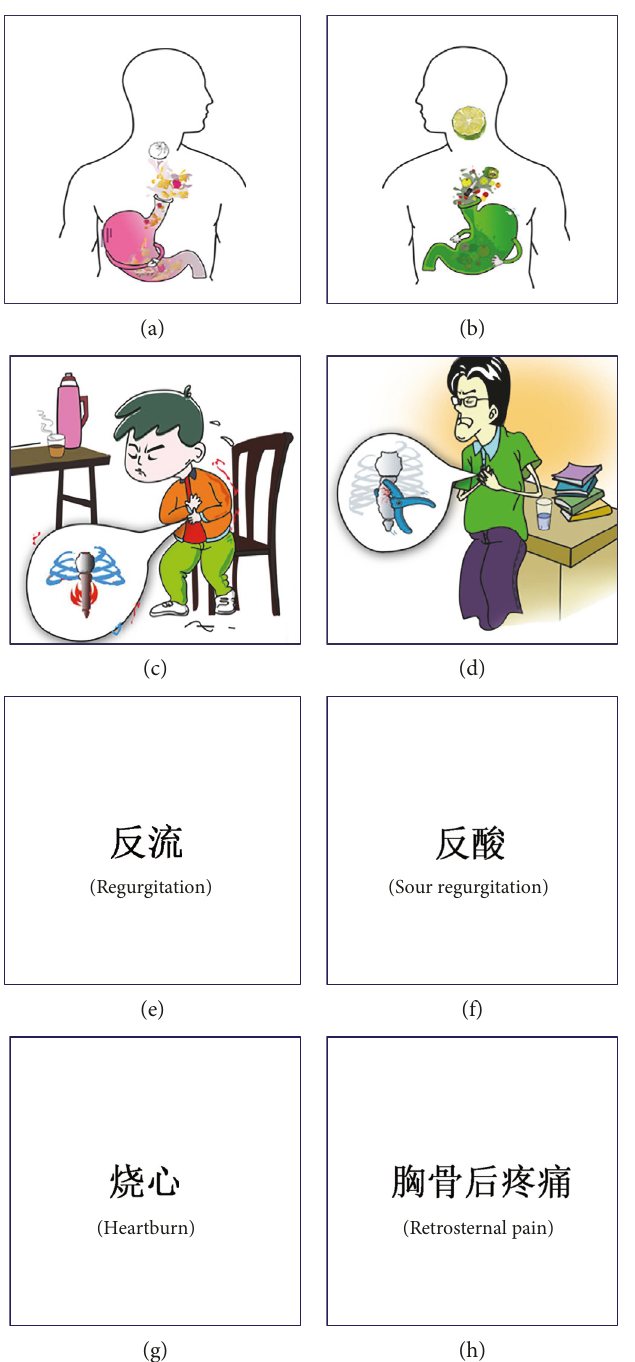
Figure 1: Pictograms denoting the classic gastroesophageal re fl ux symptoms. Pictograms denoting re fl ux symptoms were created by the joint e ff orts of an artist and a gastroenterologist specialized in GERD. (a) Pictogram denoting regurgitation, the feeling of the fl owing back of stomach contents. (b) Pictogram denoting sour regurgitation, the feeling of acidic stomach content fl owing into the pharynx and mouth. (c) Pictogram denoting heartburn, the feeling of burn behind the breastbone. (d) Pictogram denoting retrosternal pain, the feeling of pain behind the breastbone and above the xiphoid. (e) – (h) Cards with the terms of the GERD